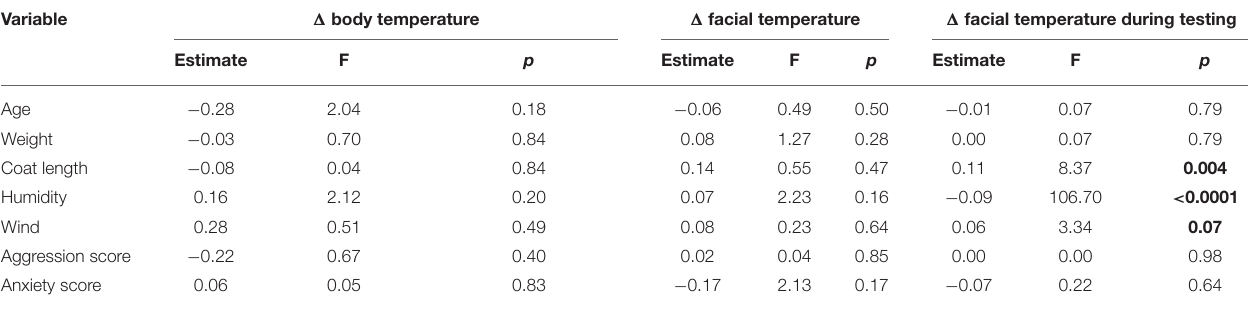
TABLE 4 | Effects of continuous variables tested on changes ( 1 ) in surface